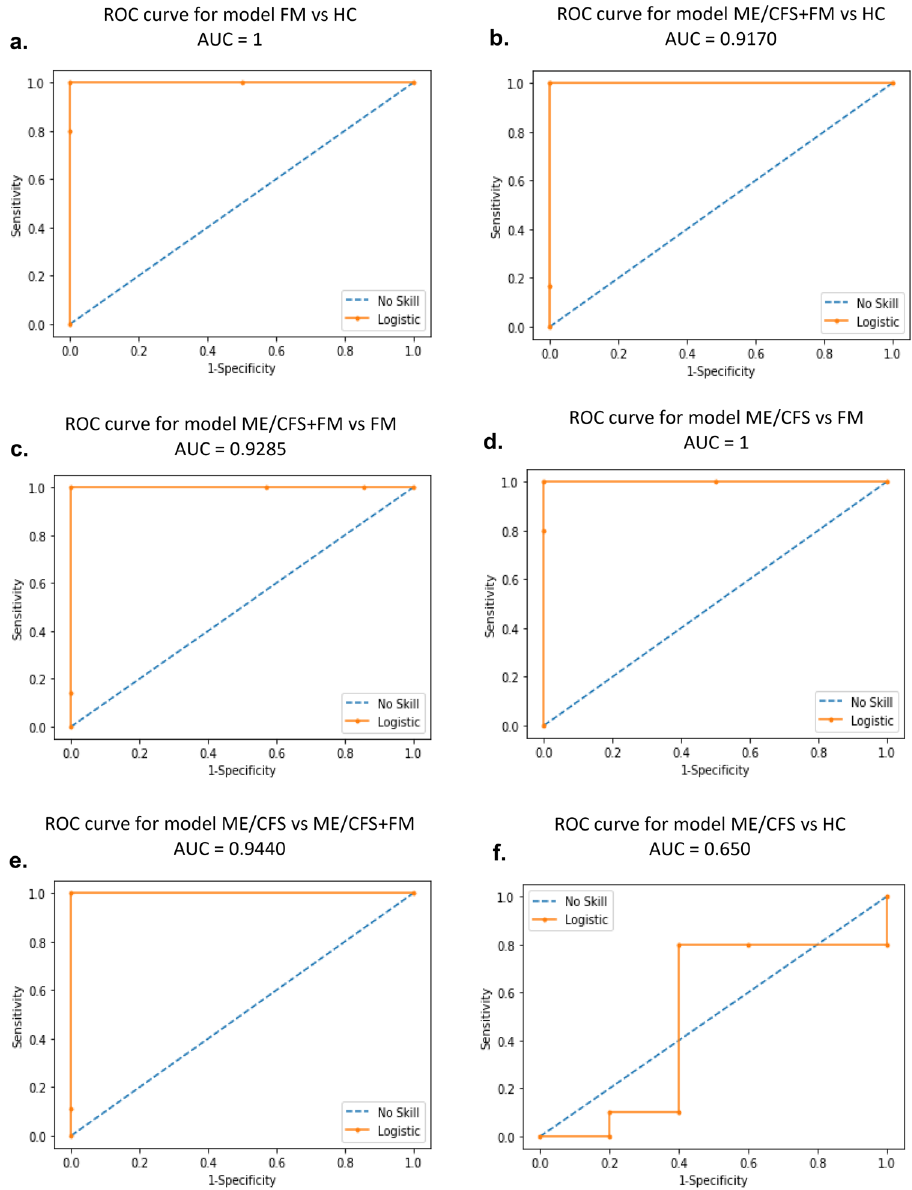
Figure 4. ROC curves for different prediction models using Random Forest Model. ( a ) ROC curve for prediction model classifying FM versus HC. ( b ) ROC curve for prediction model identifying ME/CFS + FM versus HC. ( c ) ROC curve for prediction model for classification of ME/CFS + FM versus FM. ( d ) ROC curve for prediction model identifying ME/CFS versus HC. ( e ) ROC curve for prediction model classifying ME/CFS versus ME/CFS + FM. ( f ) ROC curve for prediction model identifying ME/CFS versus